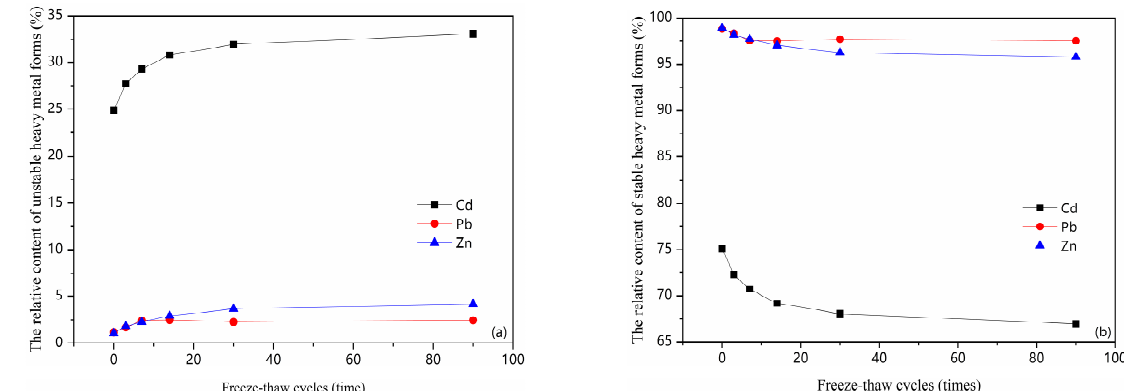
Figure 4. The variation of the relative content of HM forms with F–T cycles in the S/S Pb-Zn-Cd composite HM-contaminated soil. ( a ) unstable HM forms; ( b ) stable HM forms.